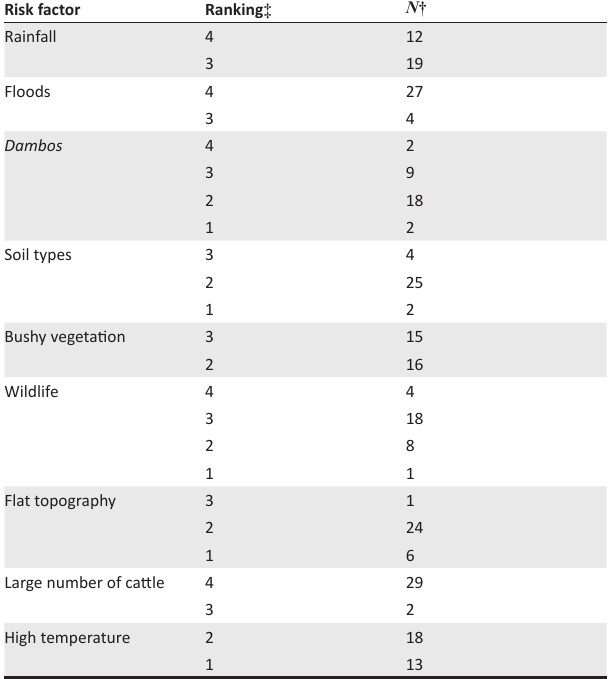
TABLE 2: Summarised results for qualitative ranking of Rift Valley fever entry risk pathway in cattle as perceived by the pastoralists’ key informants in Ijara, Kenya.